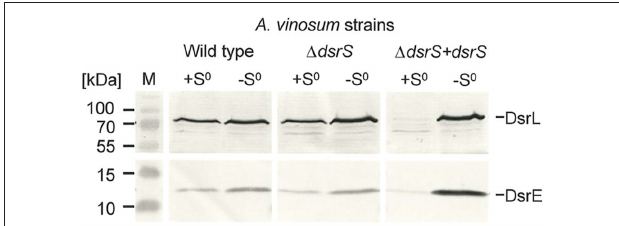
FiGurE 2 | immunological detection of dsrE (14.6 kda) and dsrl (71.4 kda) in dsrs deletion ( ∆ dsrs ) and complementation ( ∆ dsrs + dsrs ) strains in comparison to A. vinosum wild type. Cells were grown in batch culture on 2 mM sulfide and harvested either at the maximum content of intracellularly stored sulfur ( + S 0 ) or after the sulfur had been completely metabolized ( − S 0 ). Sixty-eight microgram protein of the soluble fraction were used per lane. Both antisera were raised against oligopeptides comprising a highly immunogenic epitope deduced from the nucleotide sequence and their specific reaction with DsrE and DsrL overproduced in E. coli has been proven earlier (Dahl et al., 2005).